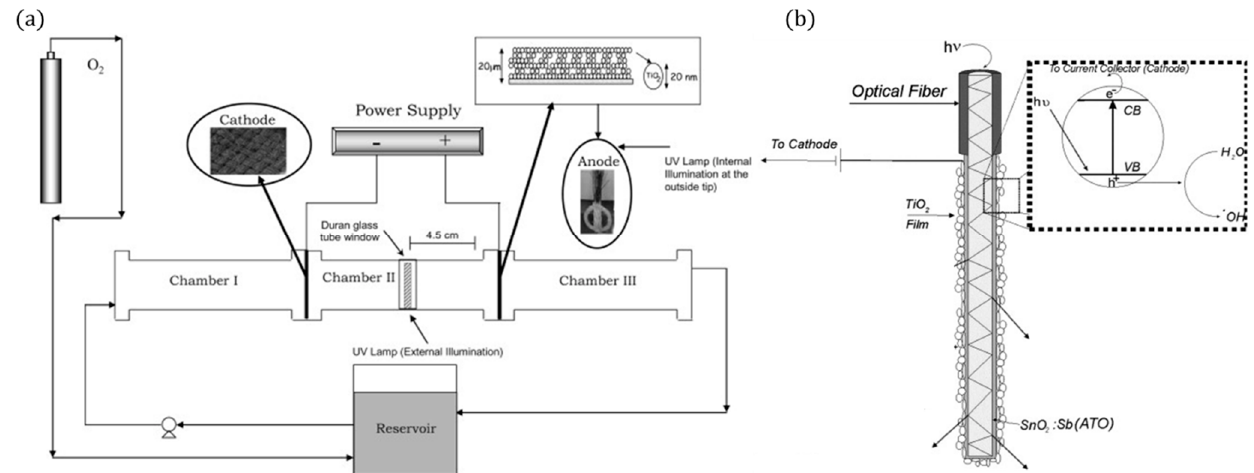
Figure 20. ( a ) Schematic representation of the experimental set-up, ( b ) fibre optic photoanode. (Adapted with permission from [85]: Esquivel, K.; Arriaga, L.G.; Rodríguez, F.J.; Martínez, L.; Godínez, L.A. Development of a TiO 2 modified optical fiber electrode and its incorporation into a photoelectrochemical reactor for wastewater treatment. Water Res. 2009 , 43 , 3593–3603, doi:10.1016/j.watres.2009.05.035. Copyright (2009), Elsevier (Amsterdam, The Netherlands)).